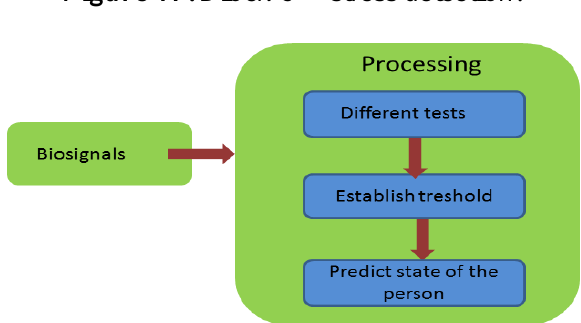
Figure 17. Block C—stress